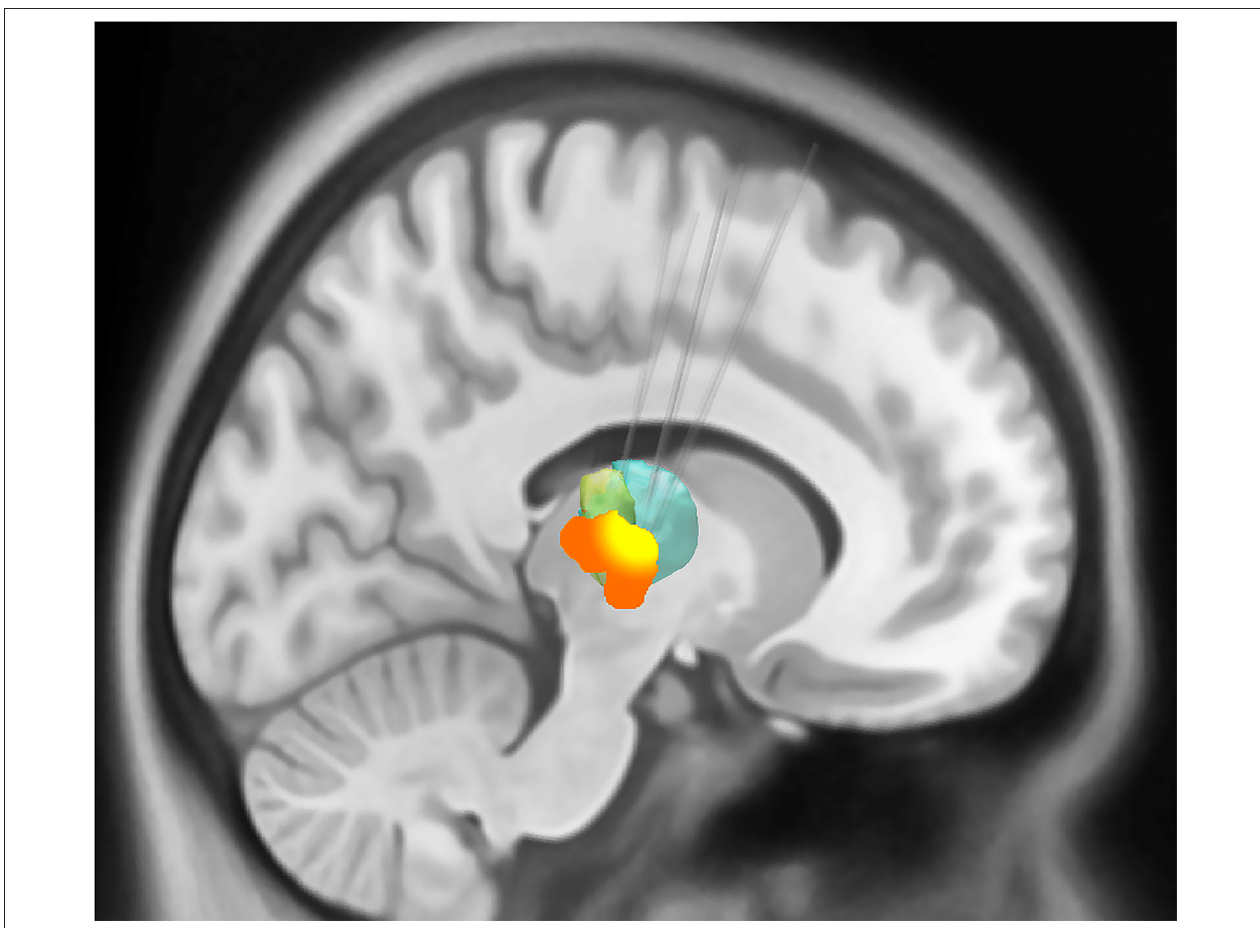
FIGURE 2 | Sagittal representation of the combined volume of stimulation from the active electrodes at the group level overlaid on the motor thalamic atlas region (Oxford thalamic connectivity atlas, Vim represented as green and ventral oralis anterior and posterior nuclei with bottle green). The group-level volumes of activated tissue (VTA) are represented in orange, while a higher overlap (80% or greater) between individual VTAs is shown in yellow color. The VIM target’s average distance from the lateral wall of the third ventricle was 10.1mm (SD 1.55). The target was on an average of 8.83mm (SD 1.35) anterior to the posterior